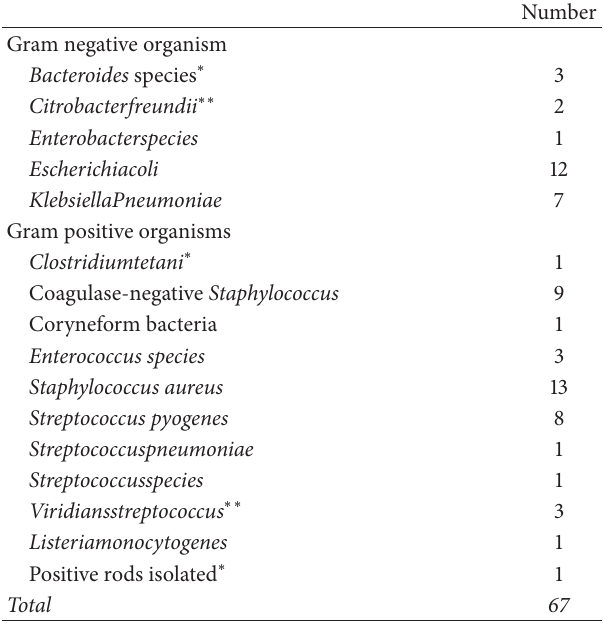
Table 2: Isolates from the positive cervicovaginal